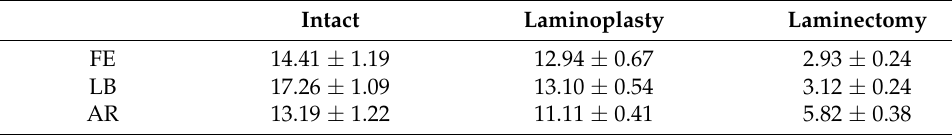
Table 4. Comparison of spinal ROM between laminoplasty and laminectomy